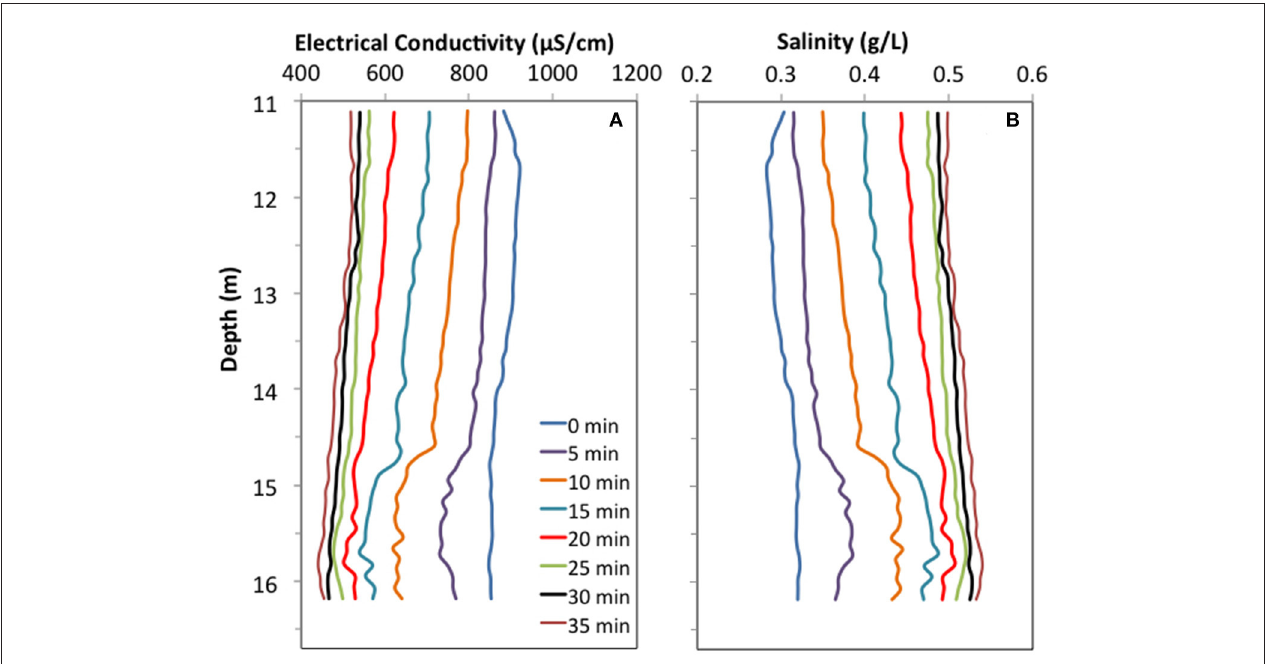
FIGURE 4 | Logging data collected at ARH well: (A) original flowing fluid electrical conductivity (FFEC) profile (t = 0min, profiles shows the background profile) and (B) modified salinity profile. The modified salinities were obtained from their corresponding electrical conductivity (ECs) by converting them using Eq. 3 and subtracting with a constant salinity value of 0.775 g/L.